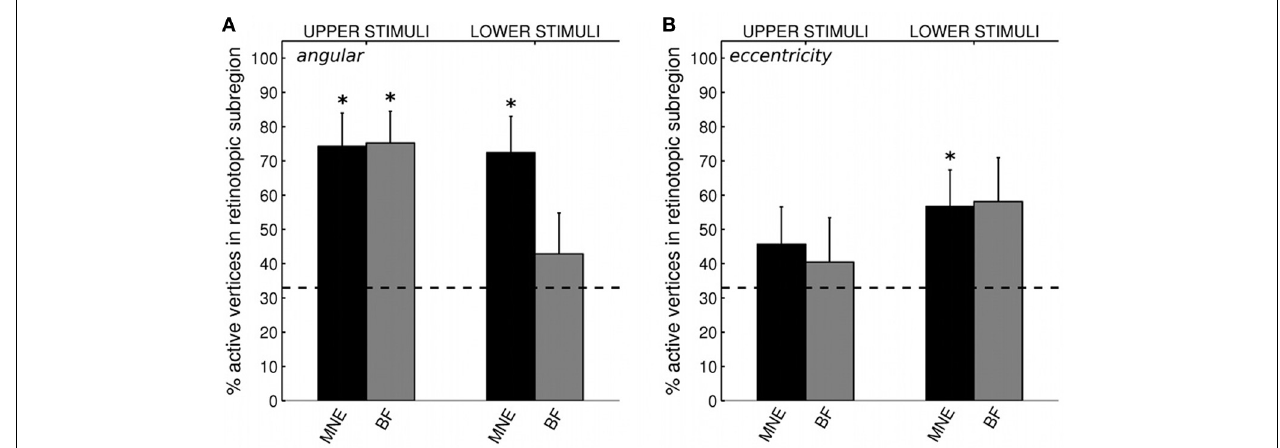
to chance ( p i < 0 . 05 with Bonferroni correction for 4 multiple comparisons). (B) Source localization accuracy, according to eccentricity, of evoked responses to quarter-ring stimuli, with MNE (black) and beamformer (BF, gray). Bars show the percentage of active vertices localized to the corresponding fMRI-defined eccentricity band, considered within the corresponding angular subregion of early visual areas V1, V2, and V3. Error bars and statistical comparisons as for (A) .